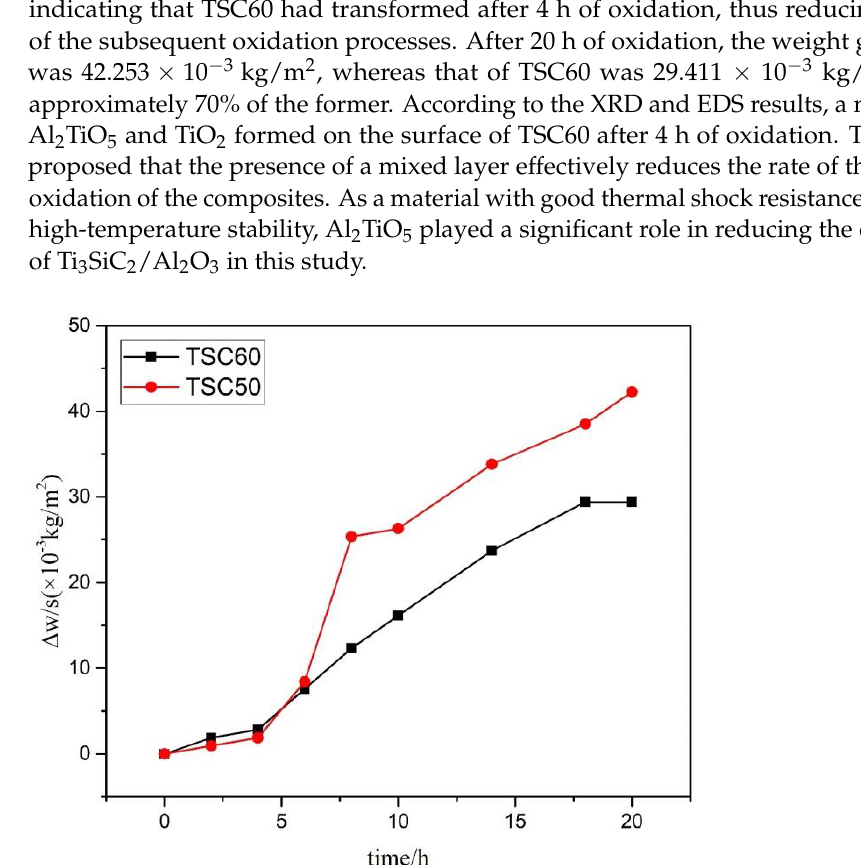
process progressed, SiO gas became a SiO 2 barrier that encapsulated TiO 2 , resulting in a condition of Si enrichment; therefore, only a small amount of Al was detected [27]. In con-